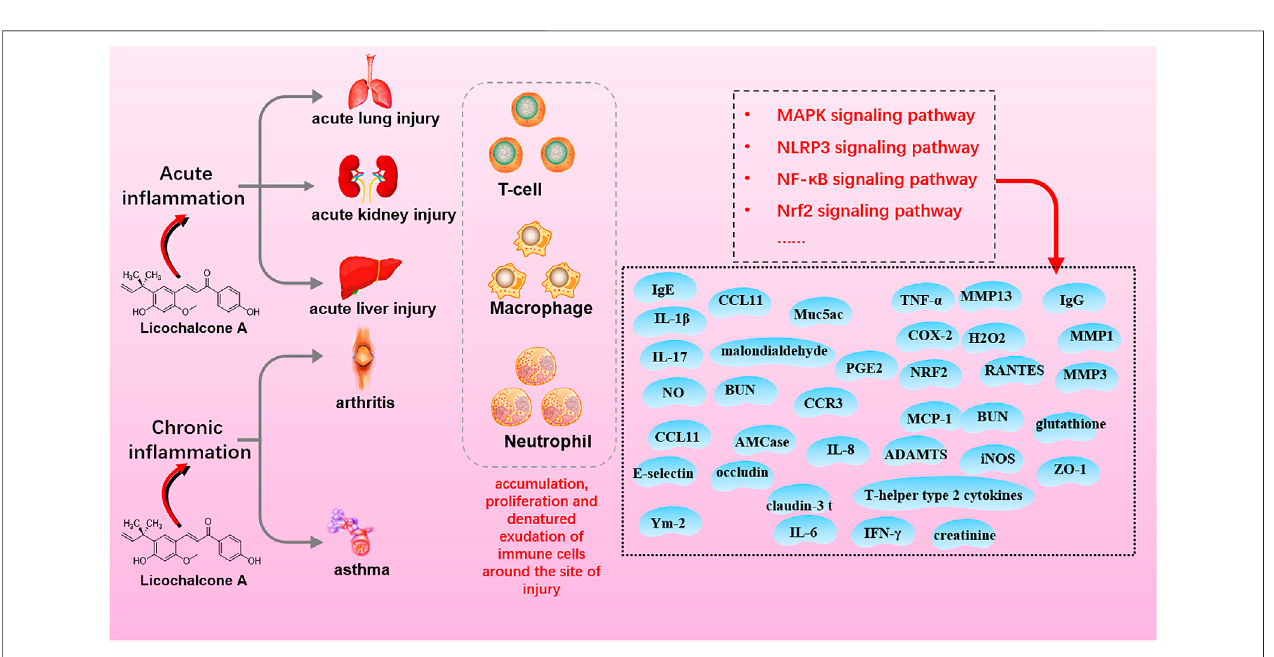
FIGURE 4 | The mechanisms of licochalcone A with anti-in fl ammation activity.